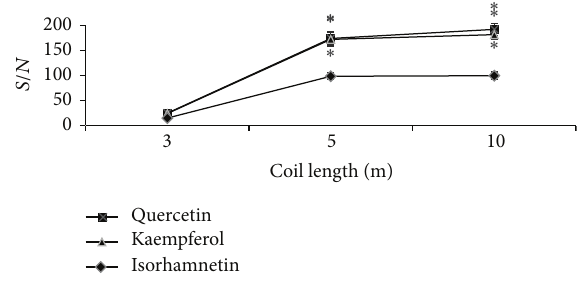
Figure 3: Signal-to-noise (𝑆/𝑁) ratios determined for quercetin, kaempferol, and isorhamnetin at different lengths of the reaction loops. ∗ indicates the significant differences at 𝑝 < 0.05